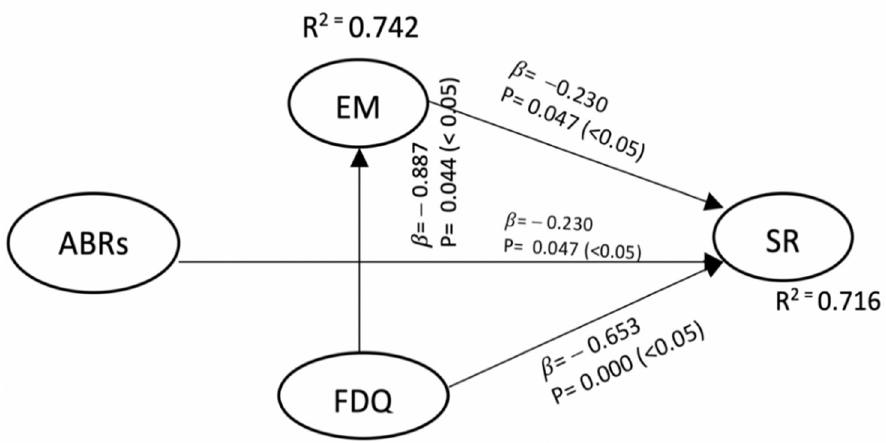
Figure 6. The Empirical Research